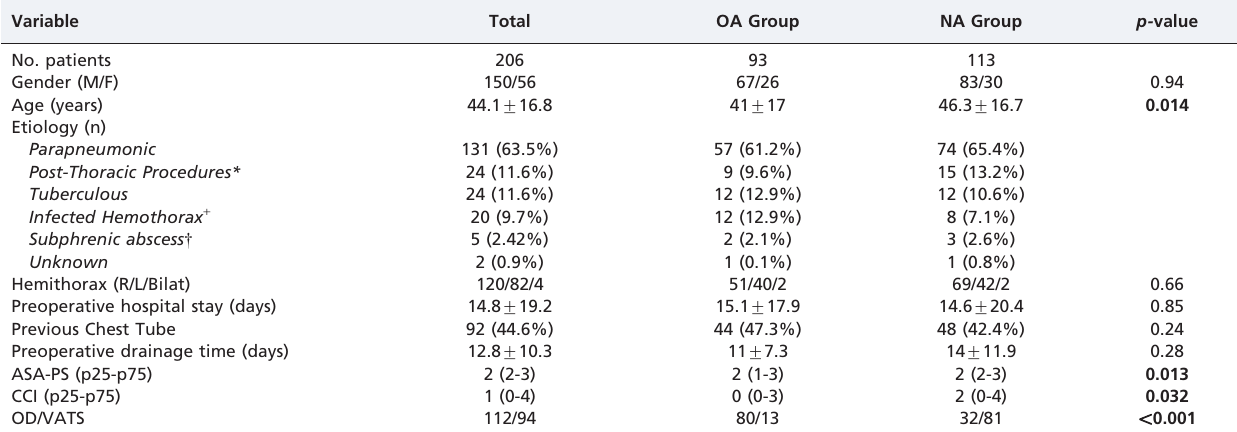
Table 1 - Total sample and group characteristics.